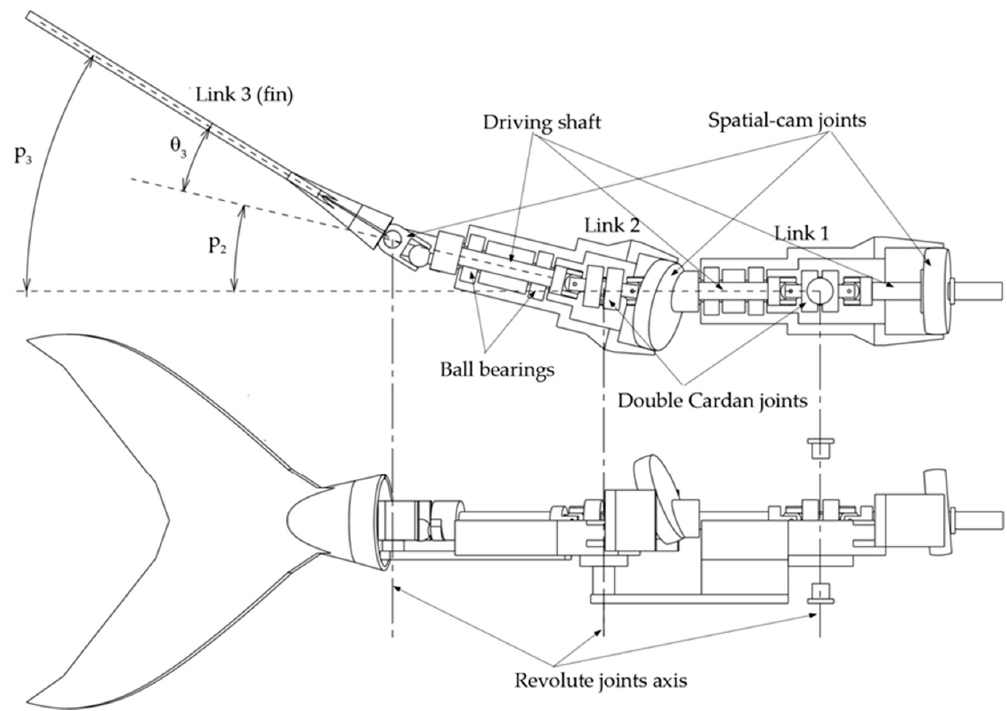
Figure 10. CAD model of the transmission system designed to drive the robotic tail at t = 0.